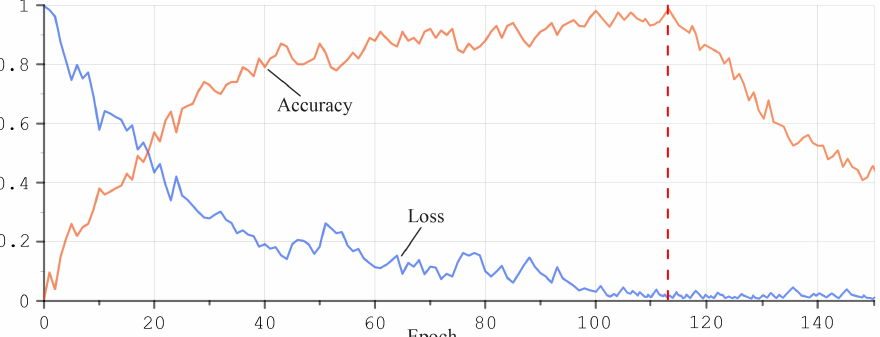
Figure 22. Dependences of the accuracy and the loss on the epoch. The red dashed line shows the epoch when the retraining of the neural network